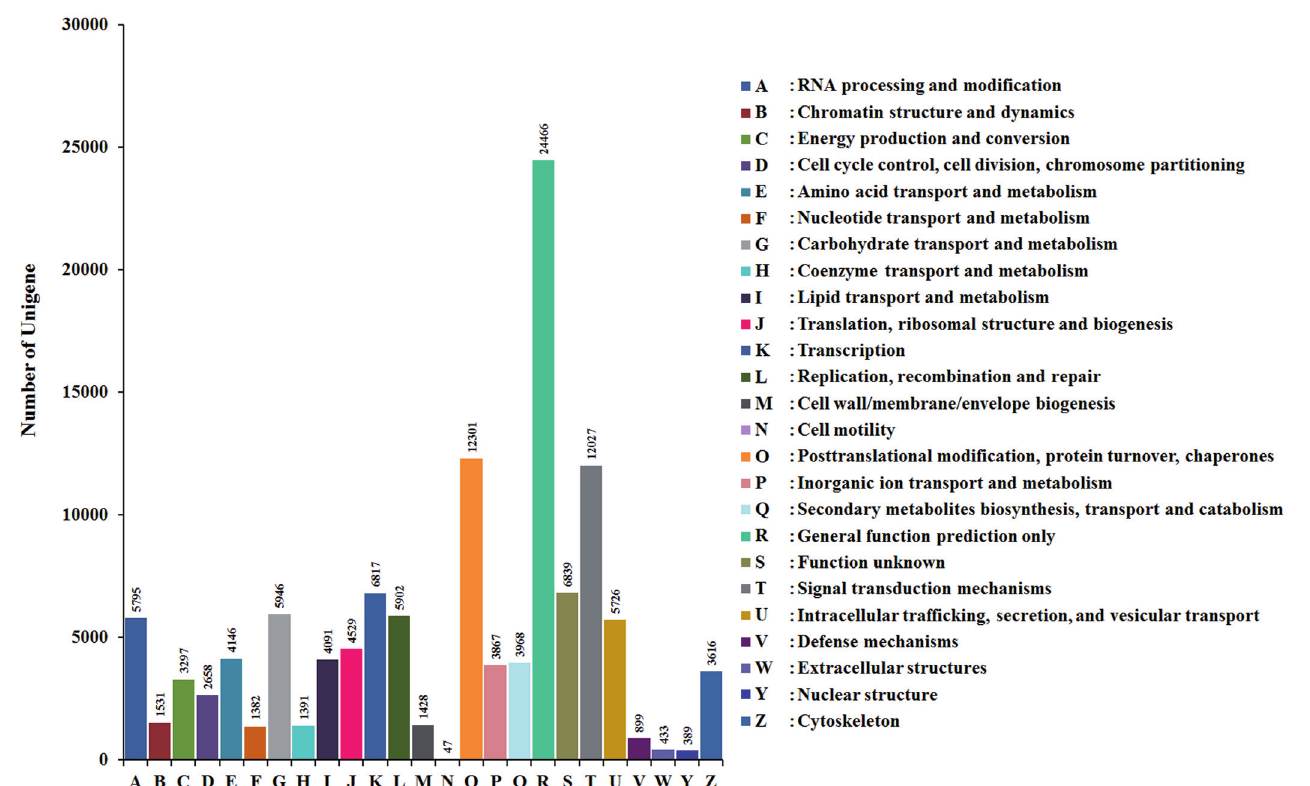
Fig. 1: Histogram presentation of the clusters of orthologous groups (COG) classification. All unigenes were aligned to the COG database to predict and classify possible functions.